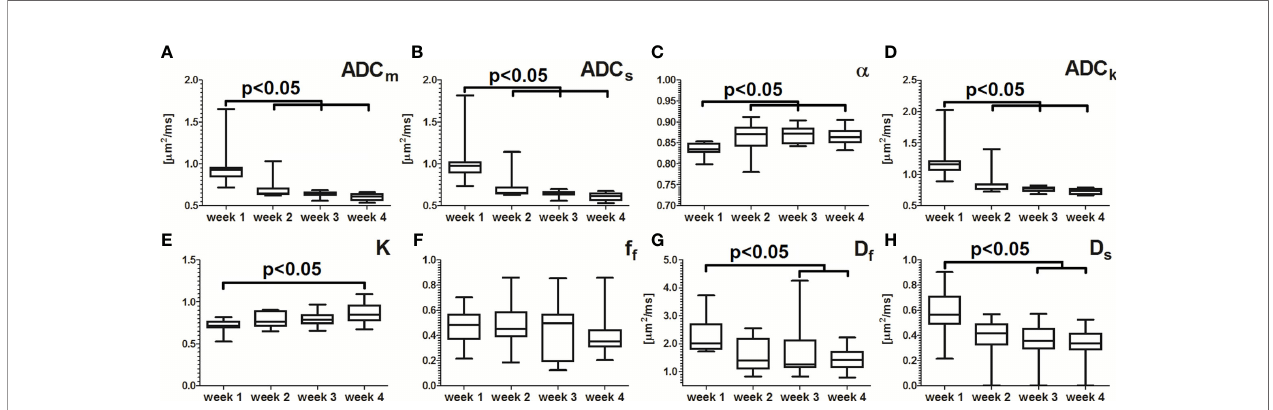
FIGURE 5 | Median values of regions of interest (n=11) derived from DWI data obtained using high b-values. Signi fi cant changes (p<0.05) were present in ADC m (part A ), ADC s (part B ), alpha (part C ), and ADC k (part D ) values between week 1 and weeks 2, 3 and 4. K (part E ) parameter differed signi fi cantly (p<0.05) between week 1 and week 4. The differences between weeks 2, 3 and 4 were not signi fi cant. Values of D f (part G ) and D s (part H ) parameters differed signi fi cantly between week 1 and weeks 3 and 4. The remaining differences in the fi tted values between weeks did not reach the level of statistical signi fi cance (Ff, part F ). The box extends from the 25 th to 75 th percentiles while the error bars extend from minimal to maximal values.